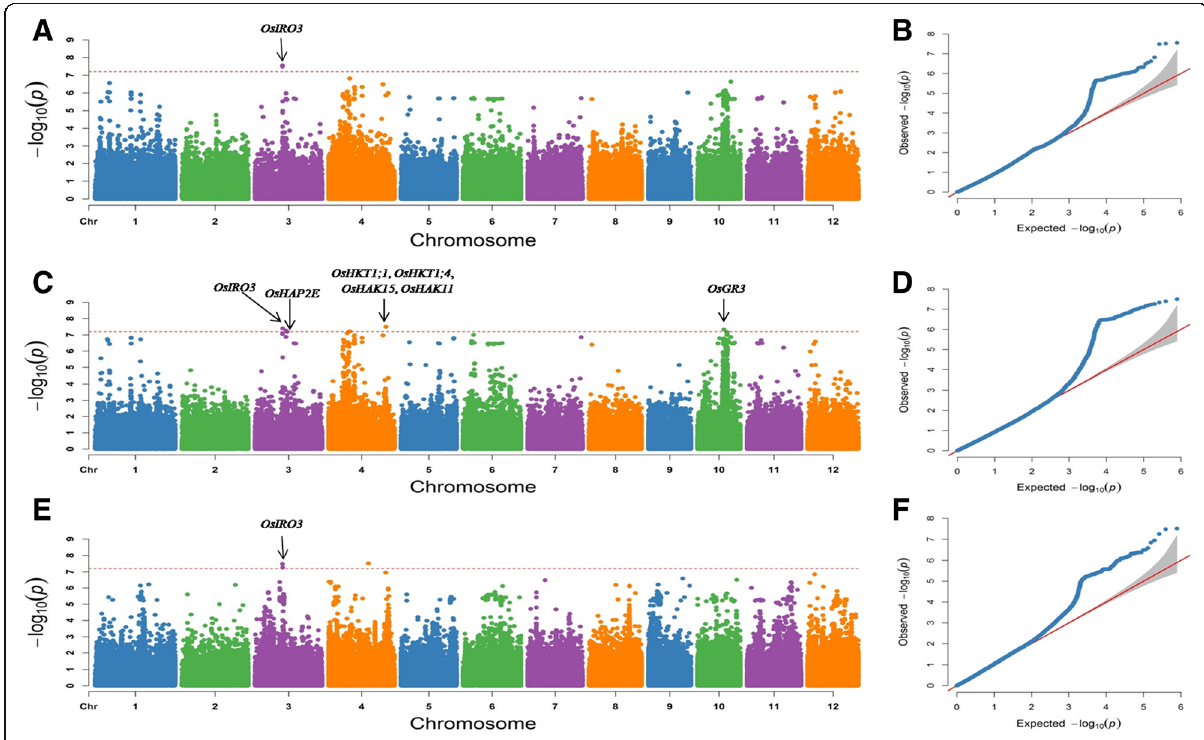
Fig. 3 Manhattan plots and quantile-quantile (Q-Q) plots of genome-wide association studies for the SNC, SNK and SAT . a , Manhattan plot for the SNC. b , Q-Q plot for the SNC. c , Manhattan plot for the SNK. d , Q-Q plot for SNK. e , Manhattan plot for the SAT. f , Q-Q plot for the